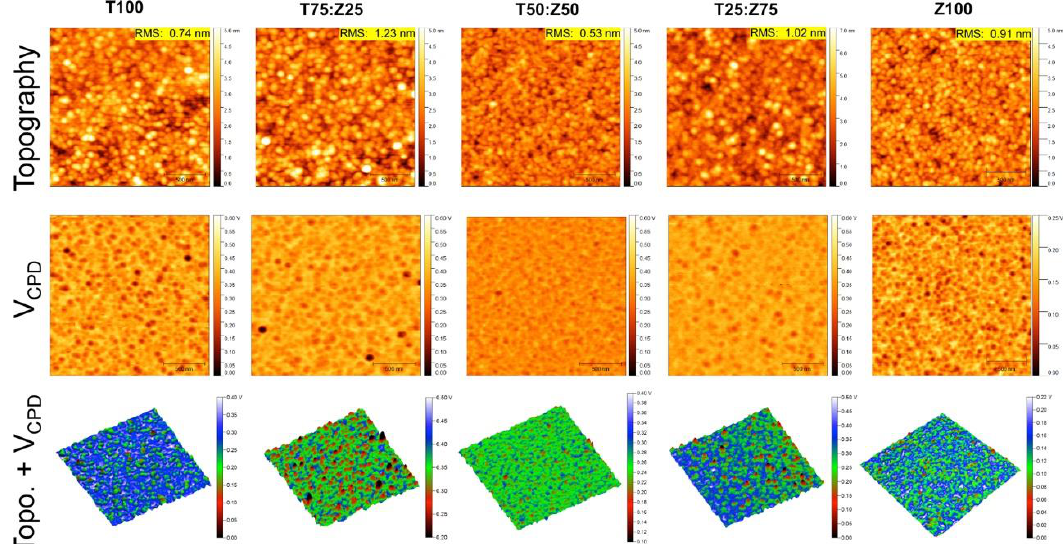
Figure 3. Topography, contact potential difference (V CPD ) and 3D map highlight variation in local charge distribution of TiO x :Zn 1−x Cd x S nanocomposite films. Scan area: 2μm×2μm.